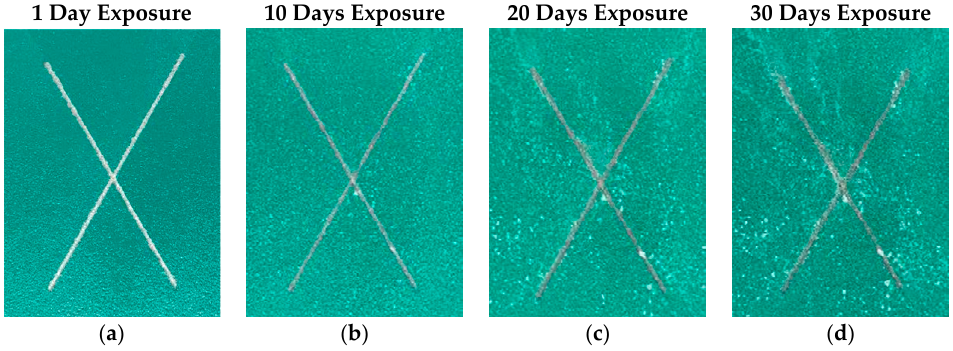
Figure 2. Appearance of coating system after accelerated exposure corrosion test of two-coat system with scribe. The values indicated below the images are the percentages of white rust area over the total area. ( a ): N.A.; ( b ): 2.43%; ( c ): 4.28%; ( d ): 6.30%.